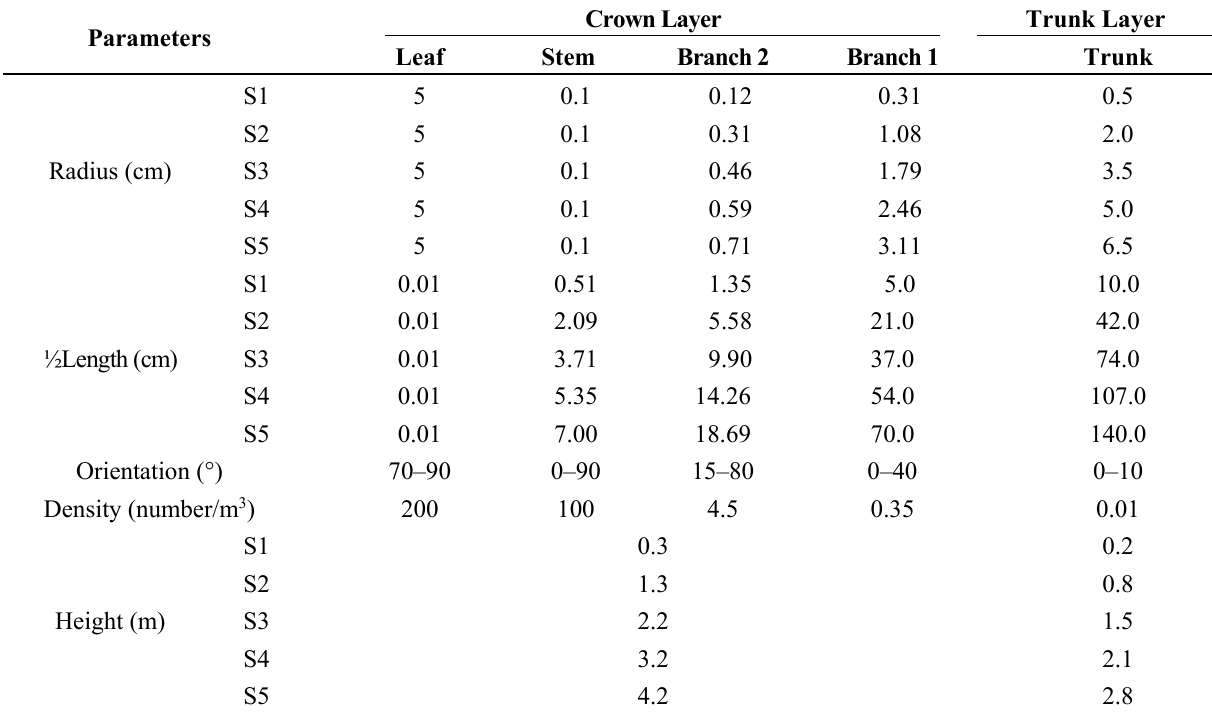
Figure 1. Schematics of five types of vegetation for simulation of polarimetric parameters. Table 1. Parameters for modeling vegetation